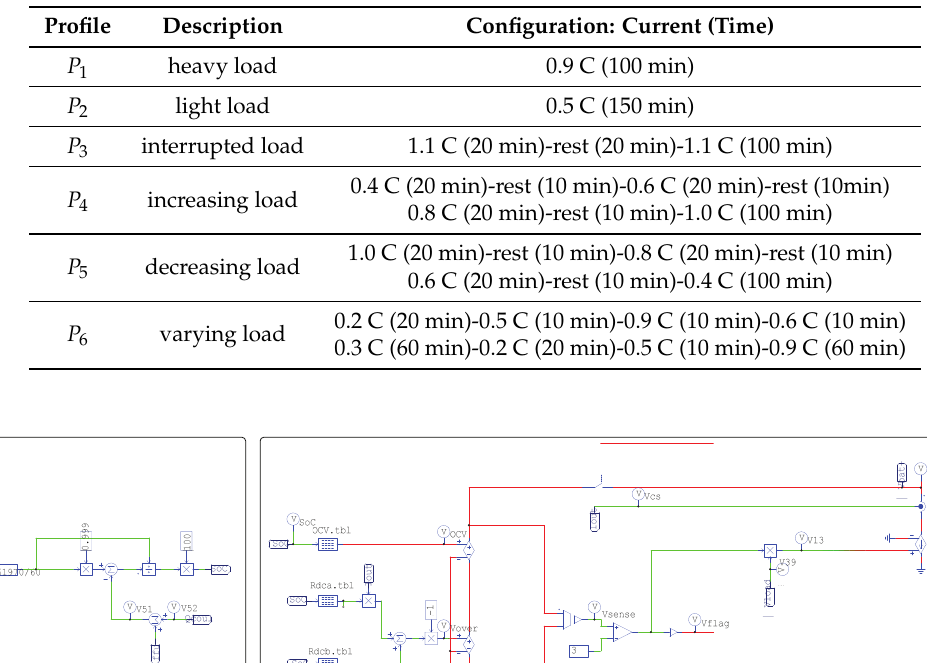
Table 1. Predefined dynamic discharging profiles.